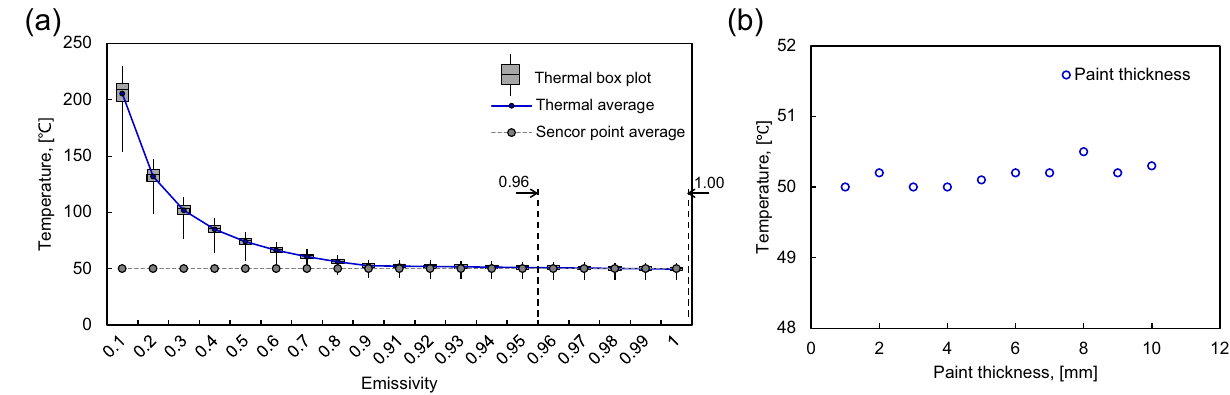
Figure 5. Deduced emissivity distributions for ( a ) comparison of values measured using thermometer versus infrared thermography; ( b ) various thicknesses of matte